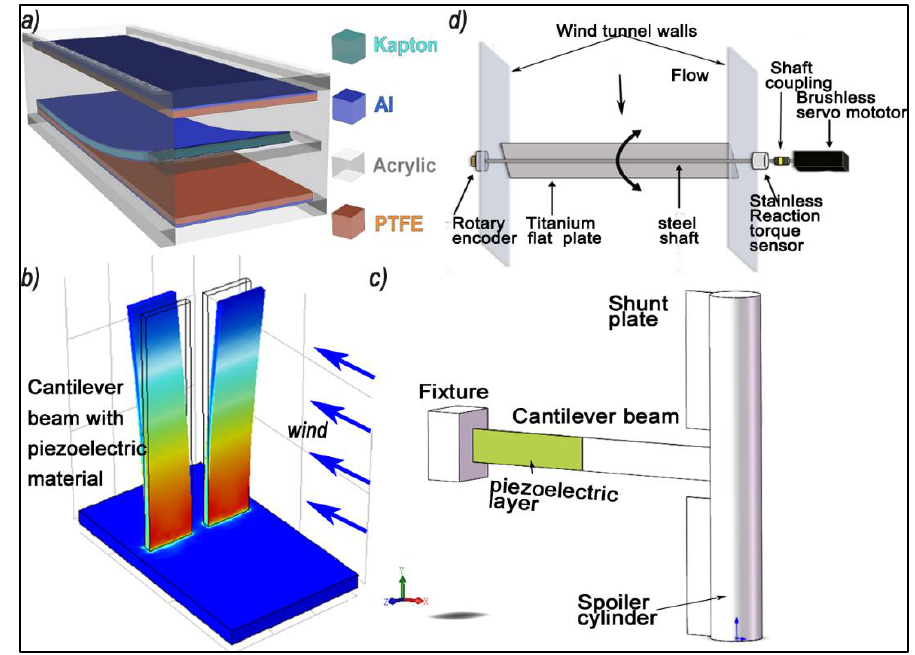
Figure 5. Schematic of miniature wind energy harvesters. ( a ) The composition of flow-driven triboelectric nanogenerators (TENG) (reproduced with permission [53]. Copyright 2015, Wiley on line). ( b ) Dual cantilever flutter (reproduced with permission [56]. Copyright 2015, The 10th International Symposium on Vibrations of Continuous System). ( c ) High wind speed energy harvester with shunt plate (reproduced with permission [58]. Copyright 2017, AIP). ( d ) Cyber-physical pitching plate energy converter (reproduced with permission [59]. Copyright 2015, Elsevier).